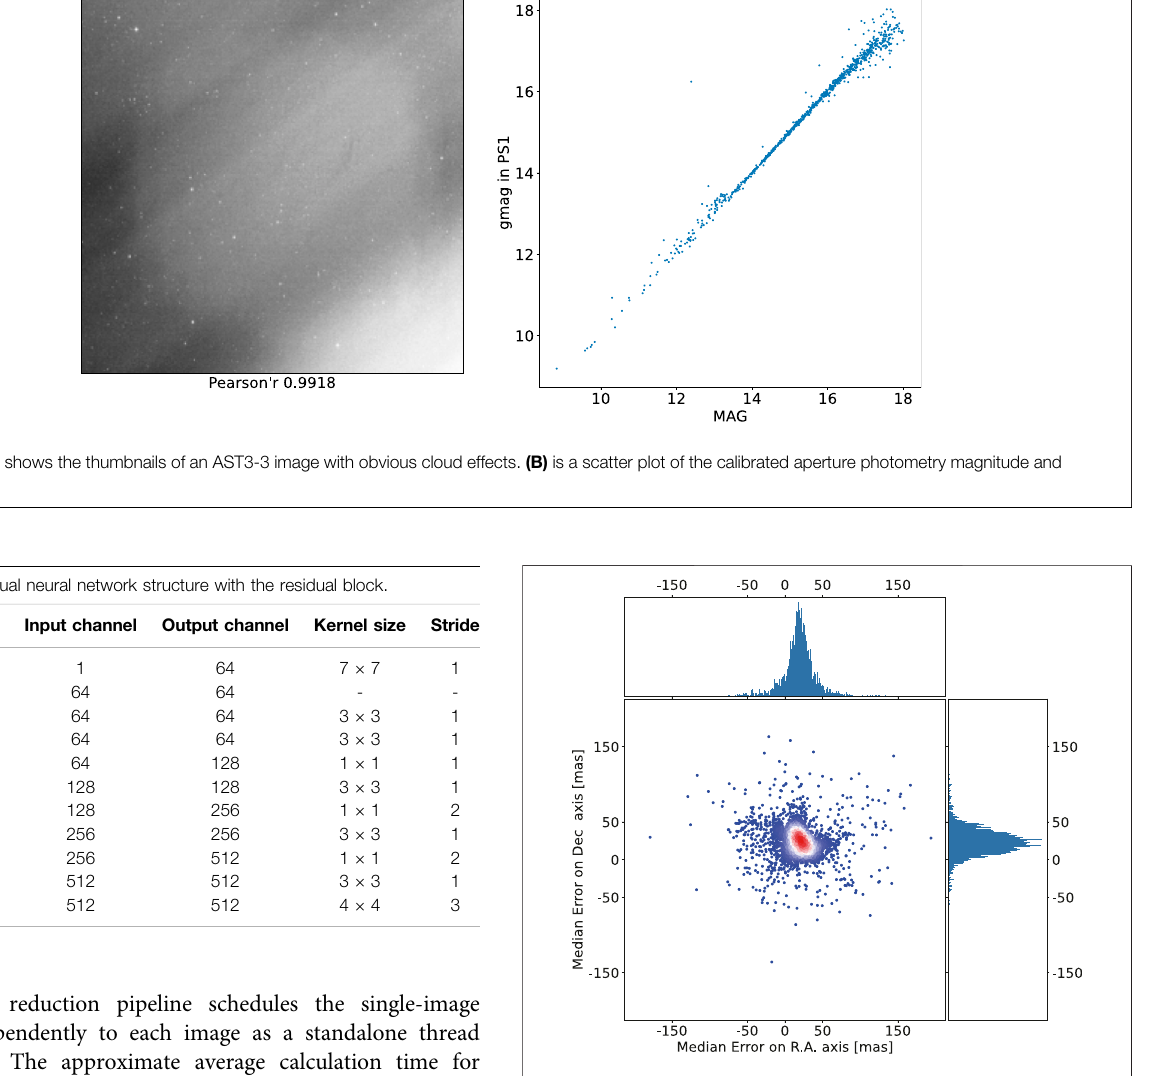
FIGURE3 | Main scatter-plot shows the median deviation distribution of the astrometric error along each axis with respect to the Gaia-DR2 catalog for AST3-3 for stars in three thousand images. The upper and right panel shows the histograms of the distributions for both